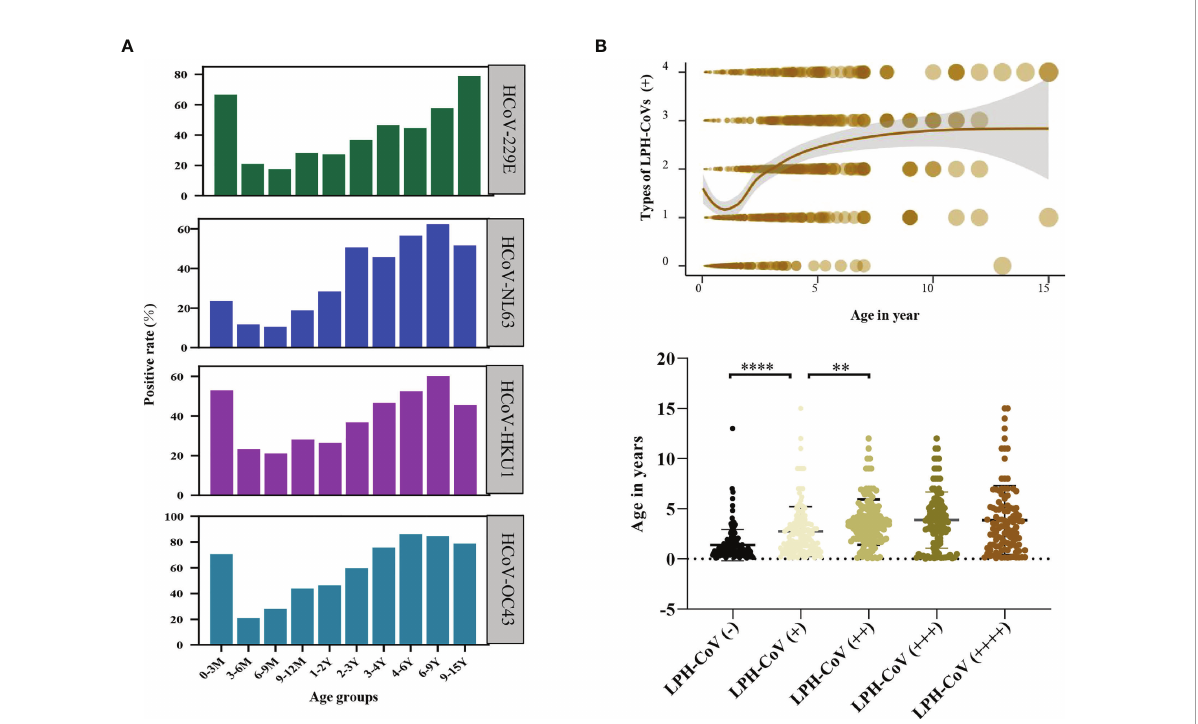
FIGURE 2 Analysis of the pre-existing antibodies response against LPH-CoVs in different age groups (A) The seropositive rates of HCoV-229E, HCoV- NL63, HCoV-HKU1, and HCoV-OC43 in different age groups. (B) The relation between age and re-infections of LPH-CoVs. The curve was fi tted by Locally Weighted Regression ( B , upper fi gure). A two-tailed P value <0.05 was considered to be statistically signi fi cant ( B , lower fi gure), (** P values of ≤ 0.01, **** P ≤